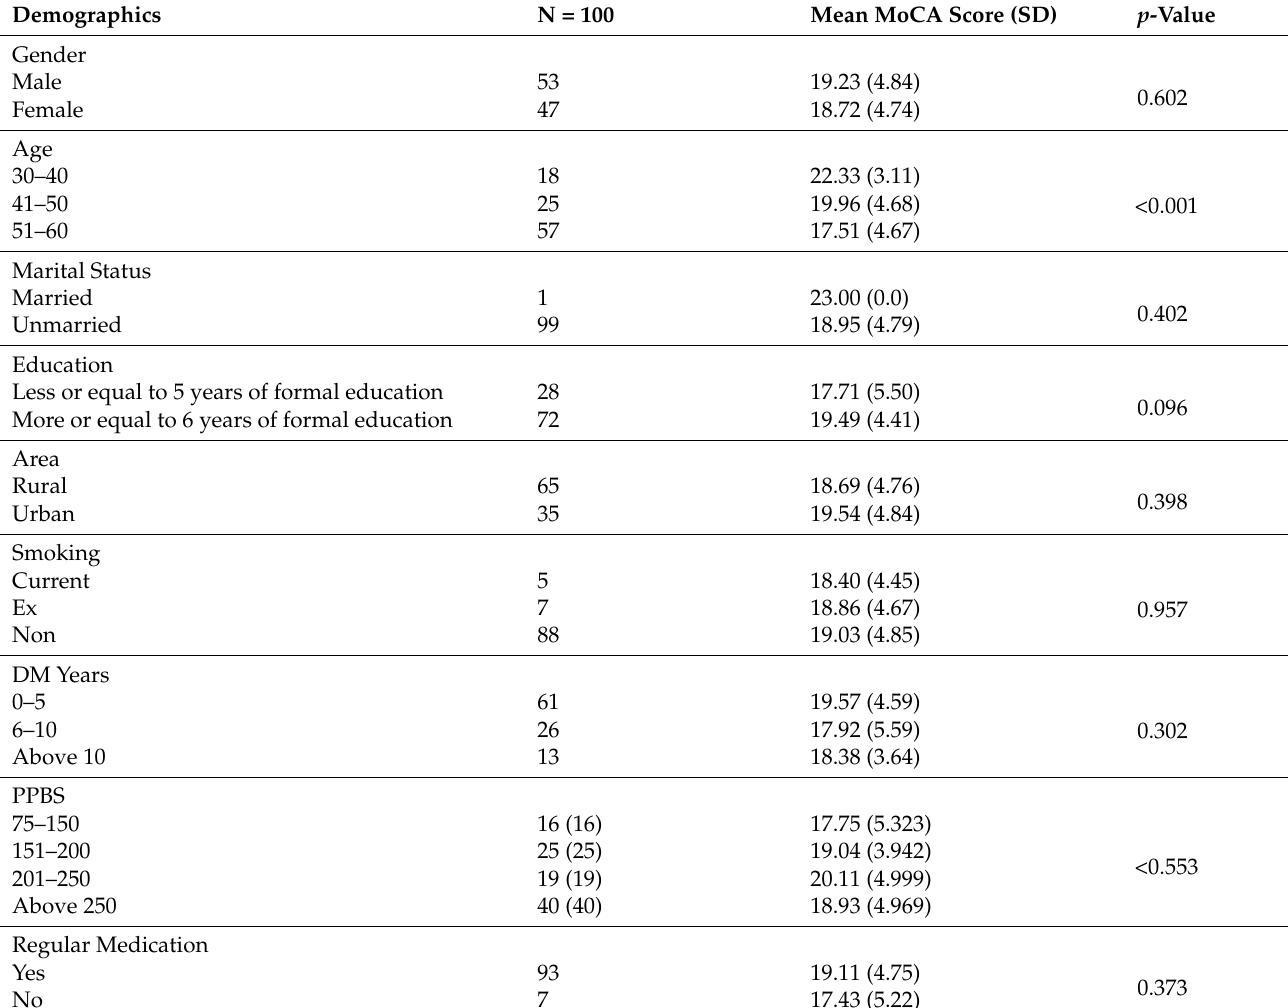
Table 3. MoCA score as per the demographics of the test